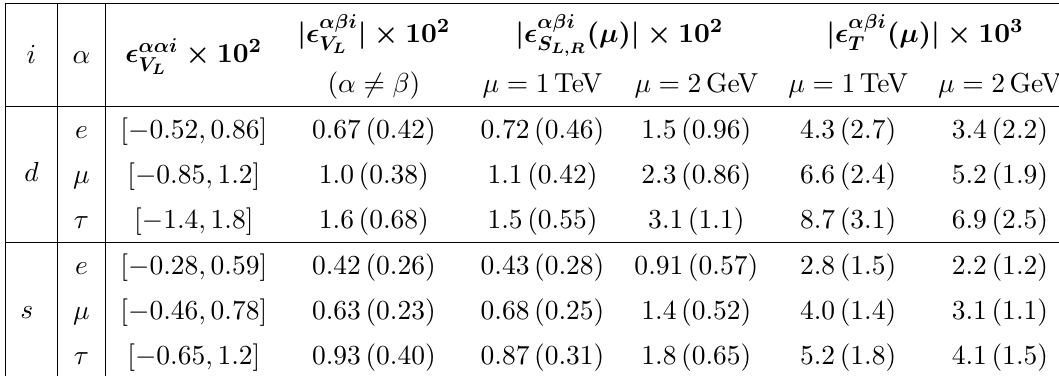
Table 4 . 95% CL limits on the value of the WCs of the charged-current operators obtained from high- p T data ( β = e, µ, τ ). We also show in parenthesis the naive projections for the HL-LHC (3 ab − 1 ) on the expected limits, assuming that the error will be statistically